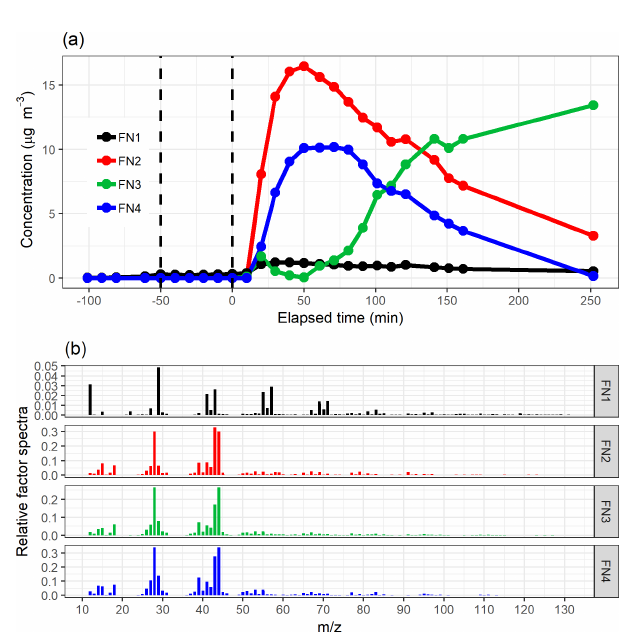
Figure 12. The factor time series (a) and relative factor spec- tra (b) from NMF with four factors for the measured particle-phase (AMS) data. The colour code identifying the factors is the same in both panels. Factors were identified as primary OA (FN1), α P- SOA-SVOOA (FN2), mixed LVOOA (FN3) and α P-SOA-LVOOA